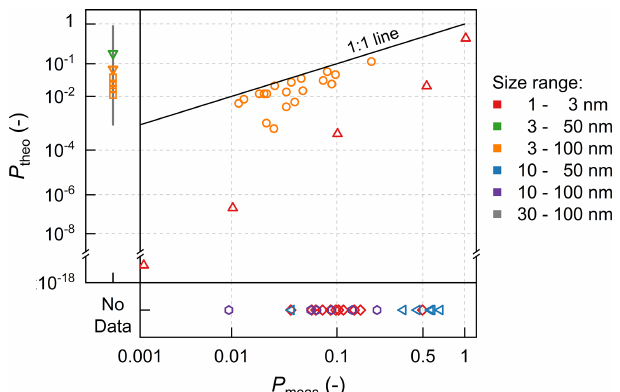
Figure A1. Particle survival probability in diverse environments. Data in this figure are collected from Weber et al. (1997), Pierce and Adams (2007), Kuang et al. (2009), Westervelt et al. (2013), Pierce et al. (2014), Kulmala et al. (2017), Zhu et al. (2021), and Sebastian et al. (2021). Data from different studies are shown in markers with different shapes. Note that the axes are not on linear